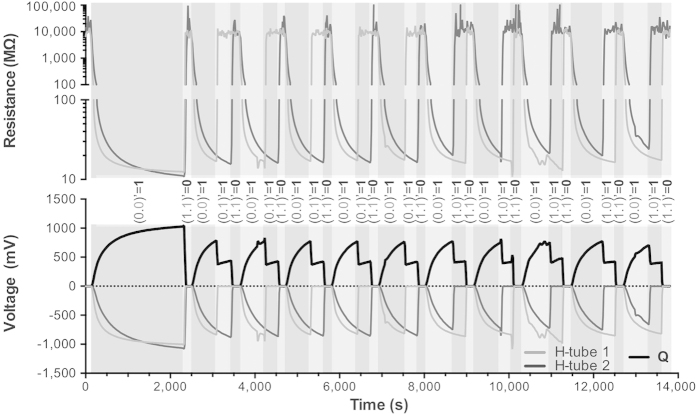
NAND behaviour of the voltage signal output of 2 H-tubes (below 0 mV curves) connected to an OpAmp (above 0 mV curve).The coloured sections indicate a manual switching. Response to stimulation is interpreted as NAND logic and expressed as (H-tube1 and H-tube2) = Output Q.